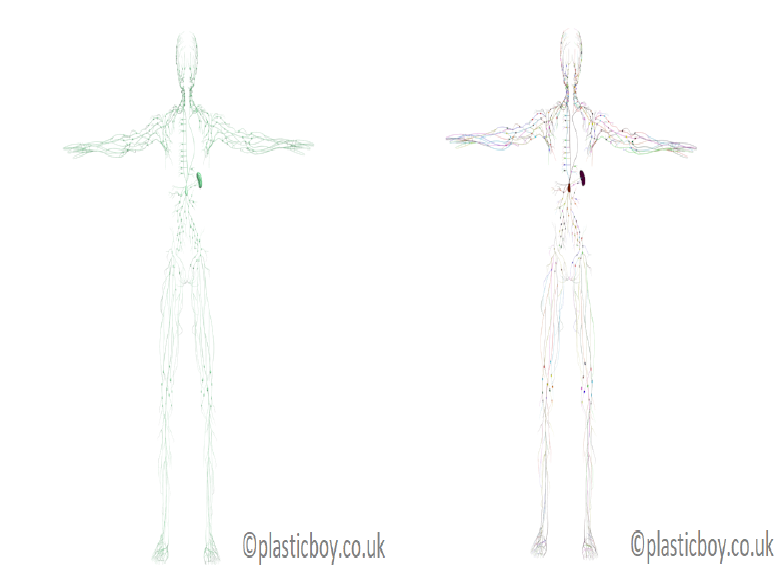
Figure 3. Global view of the 3D polygonal surface model of the lymphatic system consisting of 270 lymph nodes, 443 lymph vessels, spleen and cisterna chyli. ( Left ) Original PlasticBoy [20] model; ( Right ) the model after